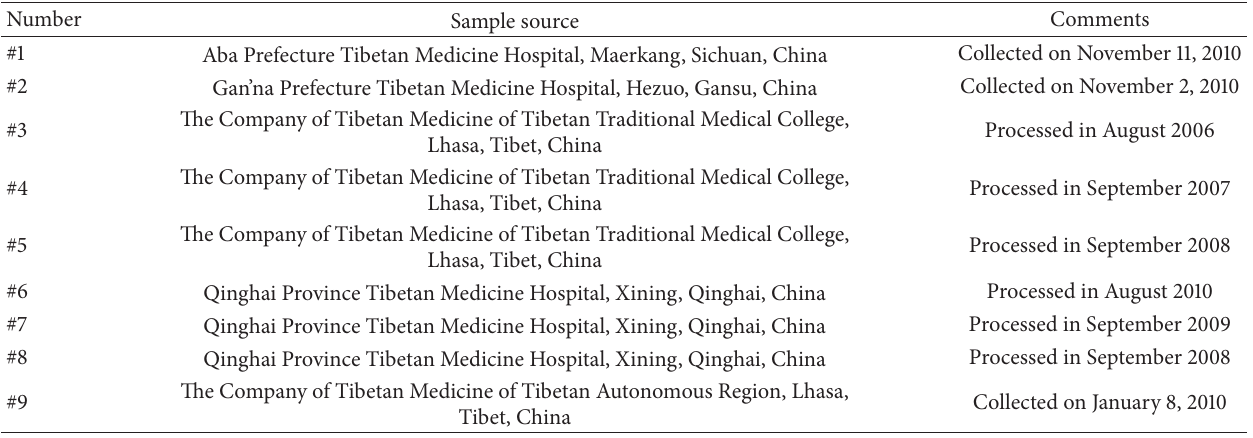
Table 1: Source of nine Zuotai